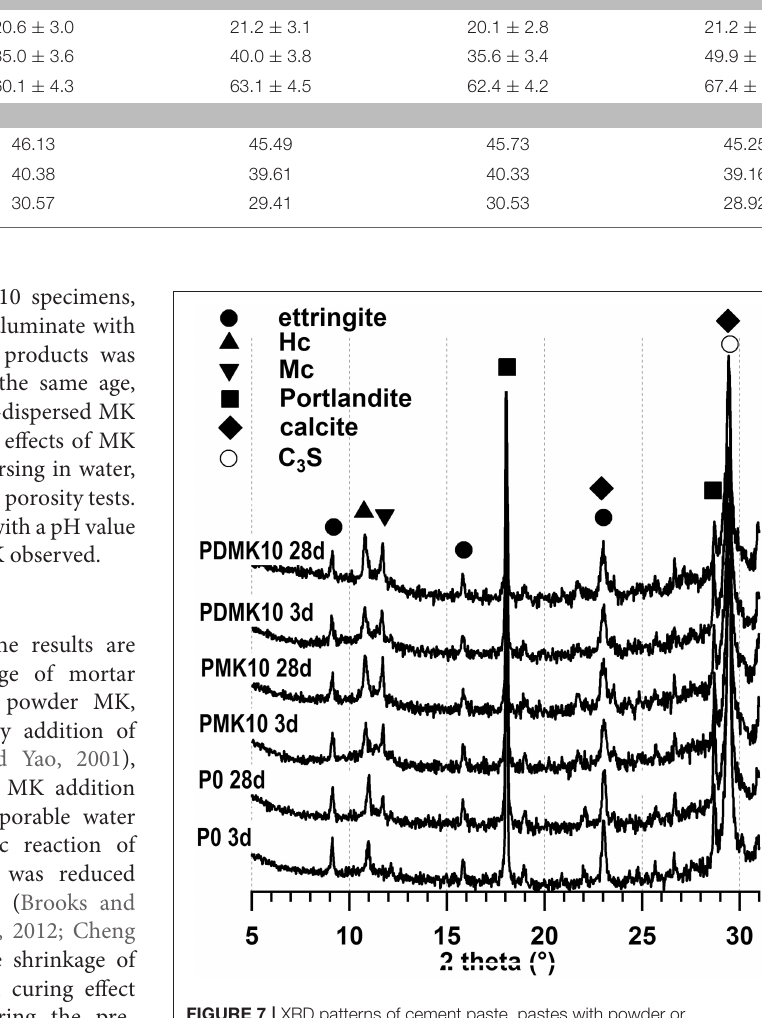
FIGURE 7 | XRD patterns of cement paste, pastes with powder or pre-dispersed MK at 3 and 28 days. Tricalcium silicate, calcite, Portlandite, monocarboaluminate (Mc), hemicarboaluminate (Hc), and ettringite were identified from these